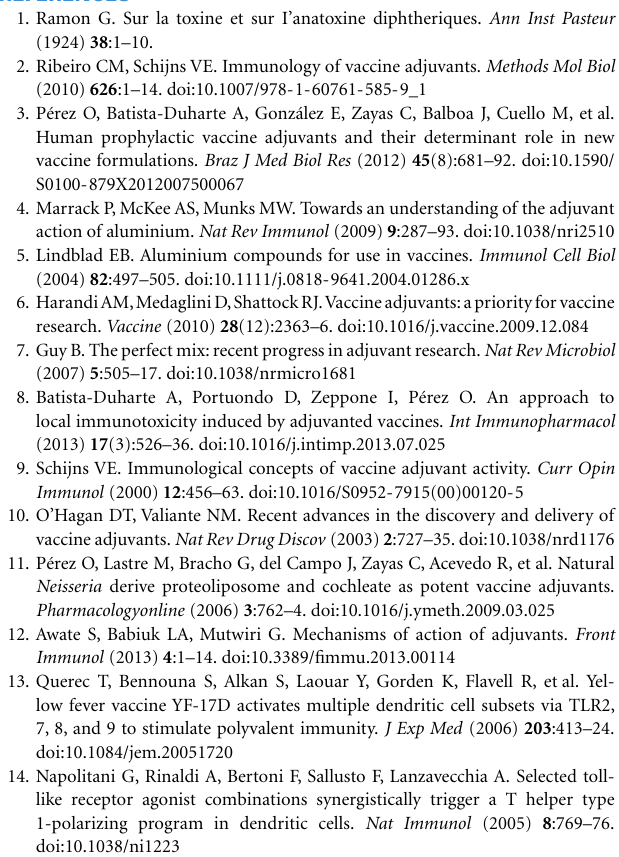
contains LPS isolated from meningococcal bacteria (54). We